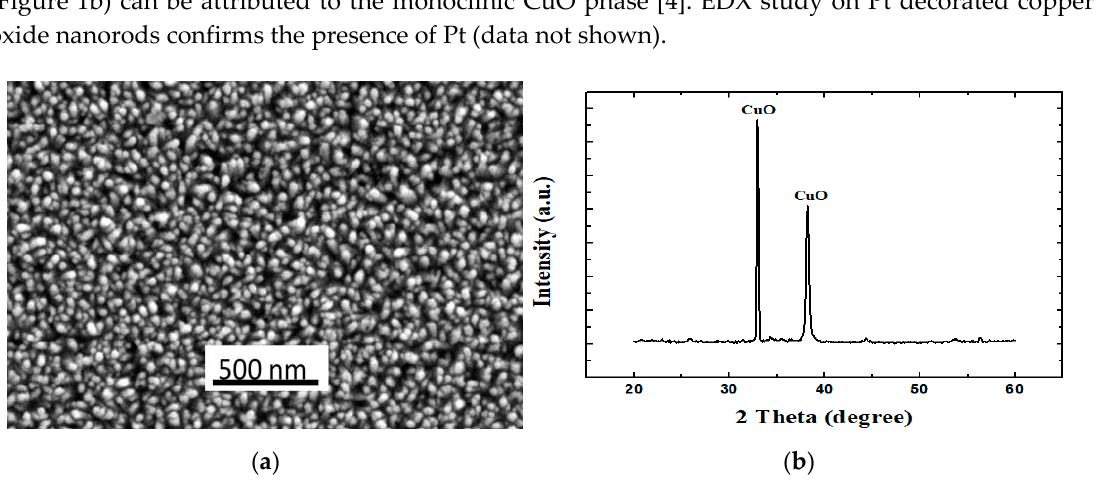
Figure 1. ( a ) SEM image of CuO nanorods; ( b ) XRD graph of CuO